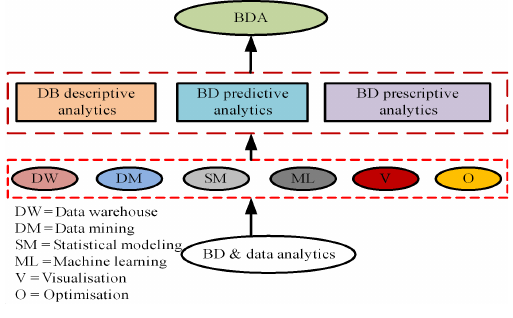
Fig. 2 A taxonomy of BDA.